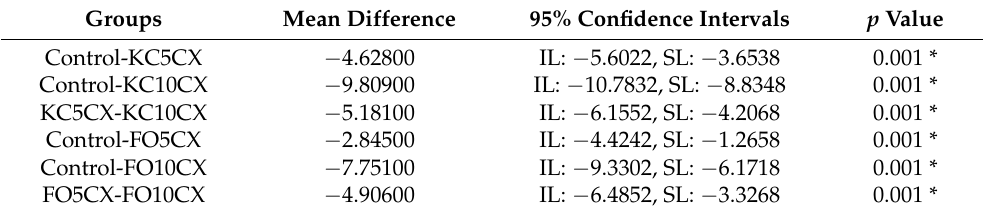
Table 4. Comparison of compressive strength between experimental and control groups.